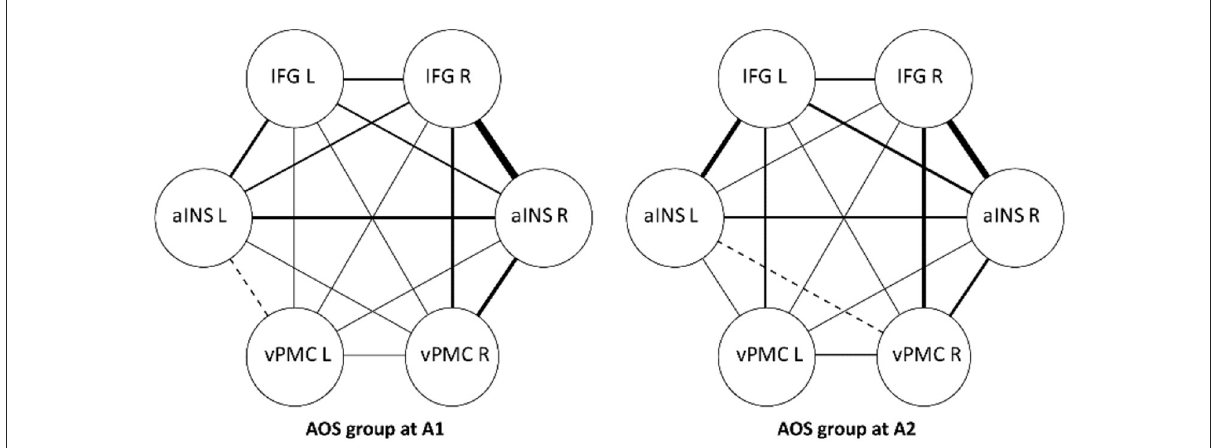
FIGURE3 Functional connectivity strength between ROIs, within group differences. Participants with AOS, aphasia and NVOA. IFG, inferior frontal gyrus; aINS, anterior insula; vPMC, ventral premotor cortex. Line thickness illustrates degree of FC strength.